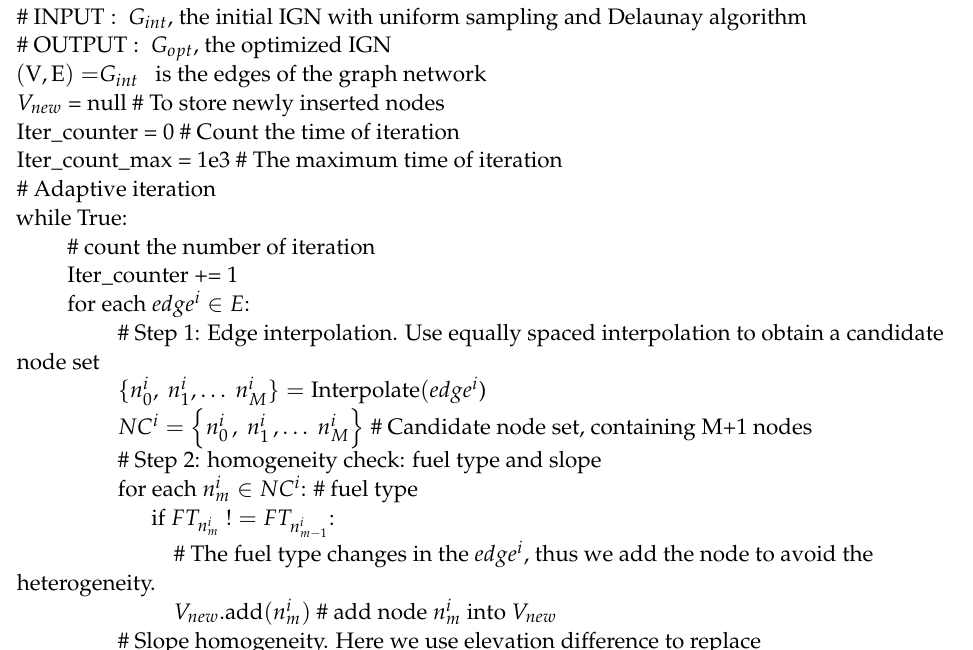
Algorithm A1 Adaptive iteration process in IGN